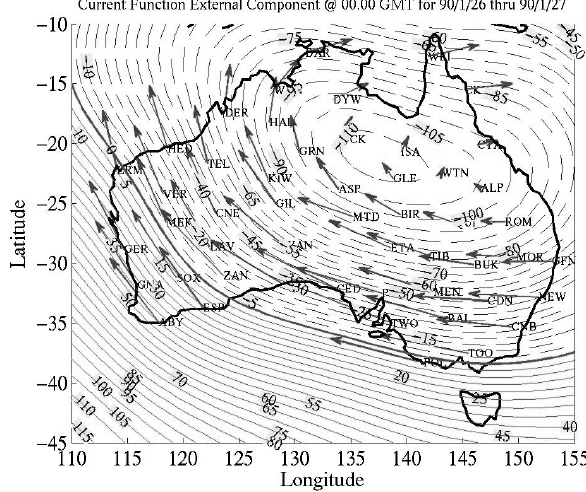
Fig 5. Current systems at 0.8 h UT on 27 January 1990, as for Fig 3. Fig. 5. Current systems at 0.8h UT on 27 January 1990, as for Fig.